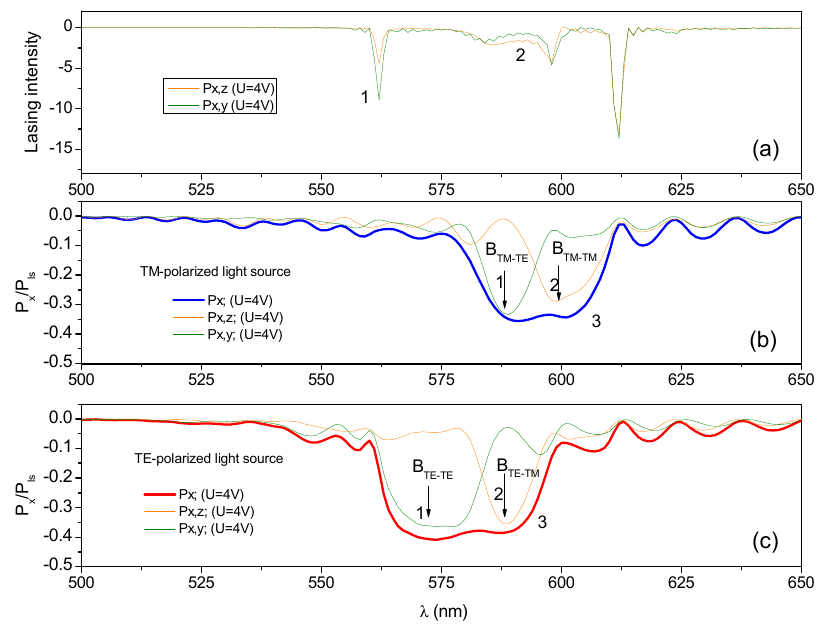
Figure 8. Spectra of the lasing effect ( a ) and corresponding reflection spectra for the case of a less-deformed (U = 4 V) lying helix. The curves labelled 1 and 2 correspond to y- and z-polarized light of the x-component of the Poynting vector (P x,y and P x,z ), respectively. The curves labelled 3 are for the total P x energy flux. The spectra ( b , c ) are for the z-(TM) and y-polarized (TE polarization) incident light.